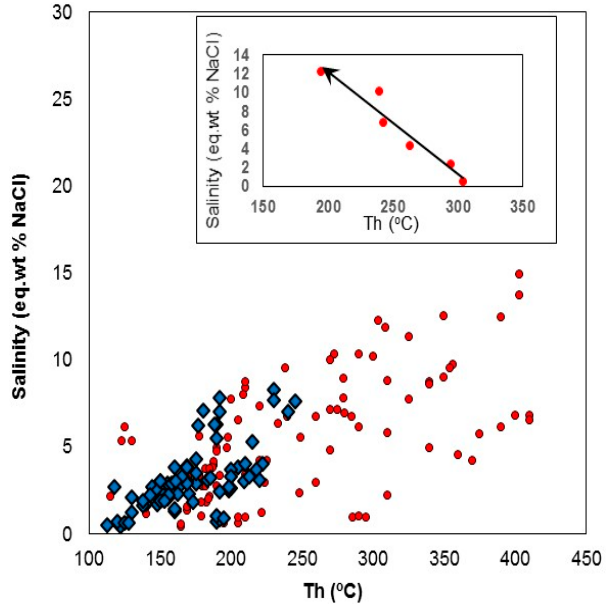
Figure 10. Salinity vs. homogenization temperature (Th) plot of fluid inclusions from quartz and barite. Internal plot shows trend of increasing salinity with decreasing temperature in sample KB-6. This observed trend is associated with a positive increase of salinity due to streamloss under boiling conditions (red point: quartz; blue point: barite).